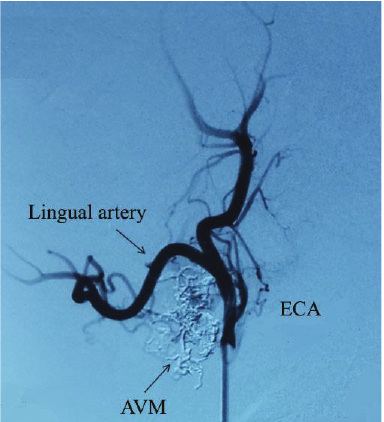
Figure 4: After the treatment digital subtraction angiography demonstrated that the arteriovenous malformations were com- pletely